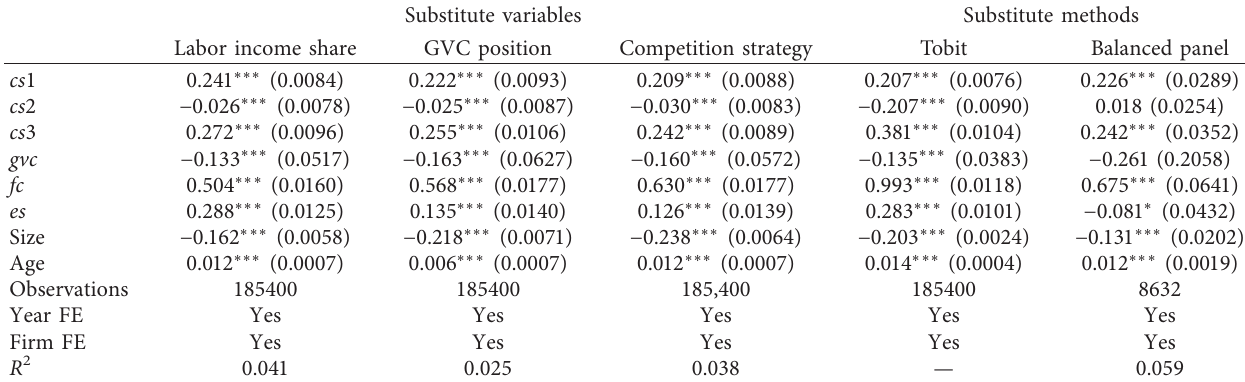
Table 3: The estimate of regressions using substitute variables and